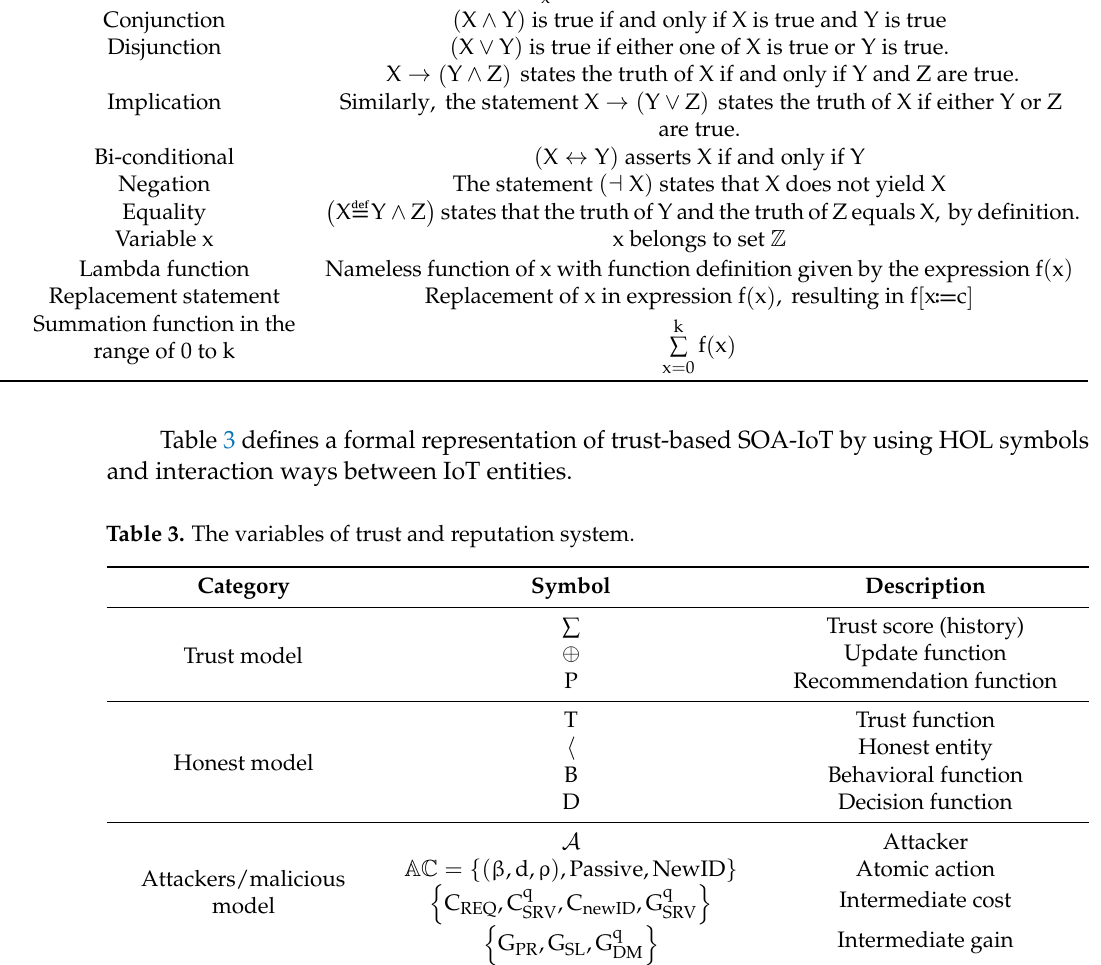
Table 2. Some logical symbols of HOL.